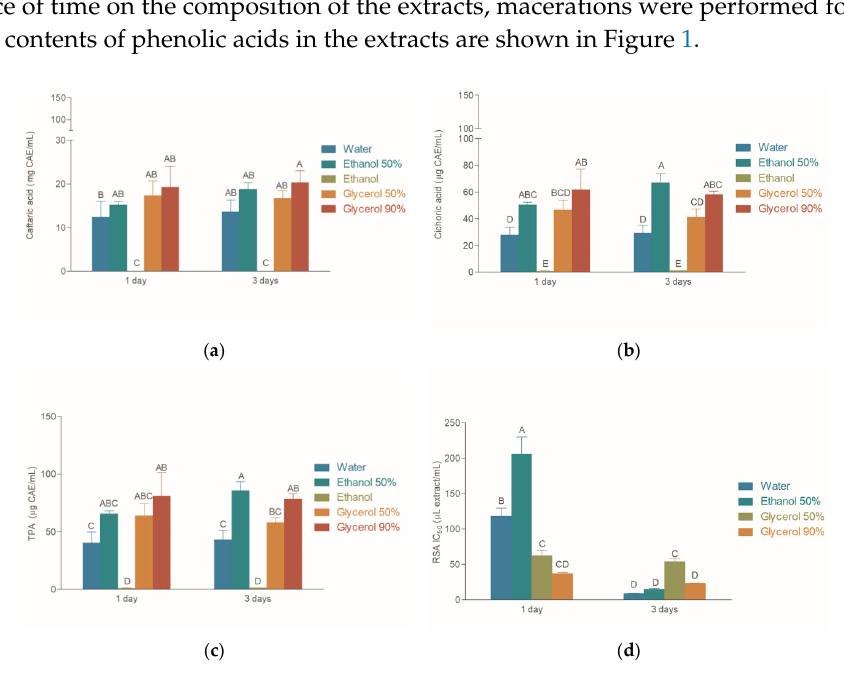
Figure 1. Contents of phenolic acids: ( a ) caftaric acid; ( b ) cichoric acid; ( c ) total phenolic acids (TPA); ( d ) radical scavenging activity (RSA) of the extracts prepared by maceration.